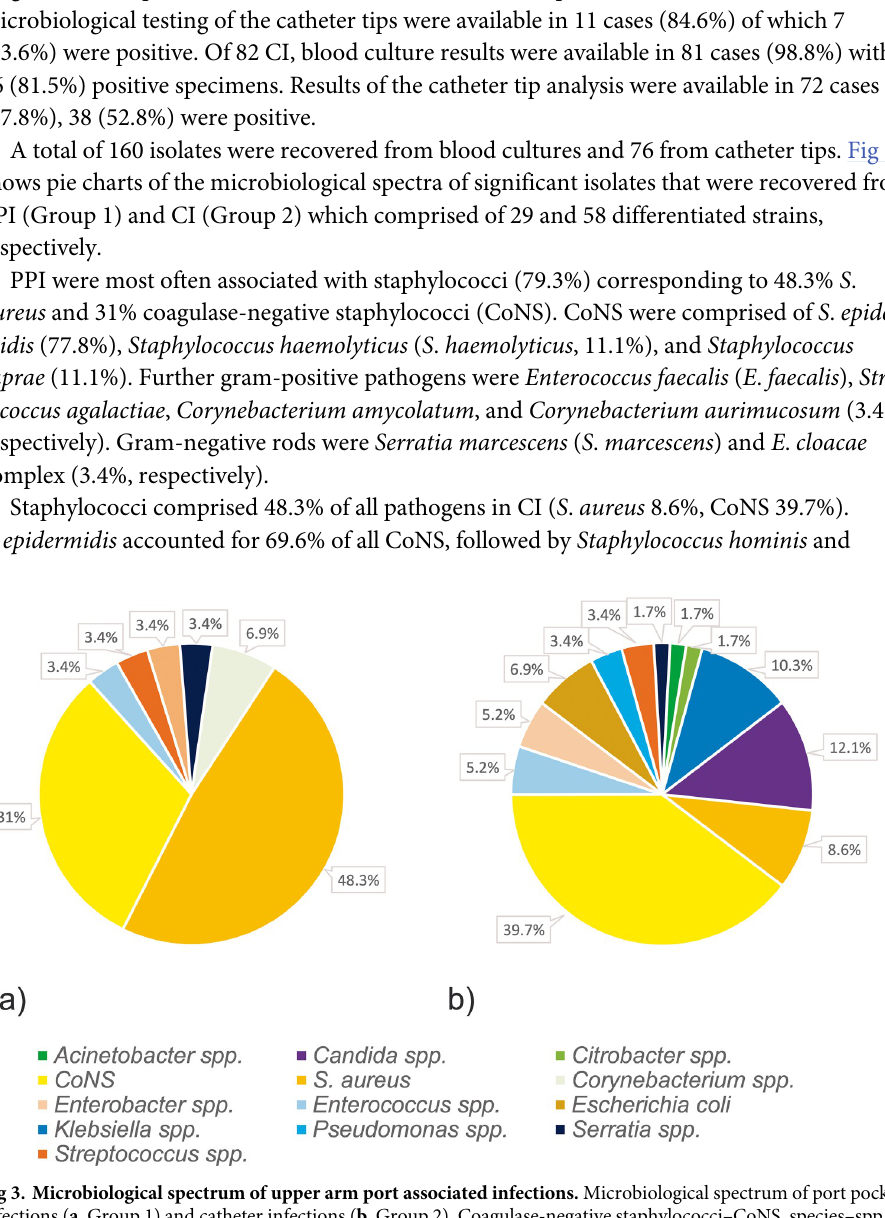
PLOS ONE | https://doi.org/10.1371/journal.pone.0284475 April 13,